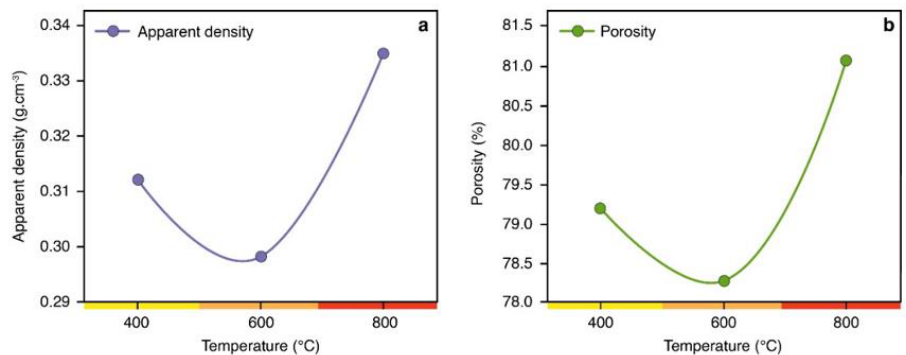
Figure 1. ( a ) Apparent density and ( b ) porosity of charcoal fines produced at different Figure 1. ( A ) Apparent density and ( B ) porosity of charcoal fines produced at different pyrolysis temperatures. pyrolysis temperatures.